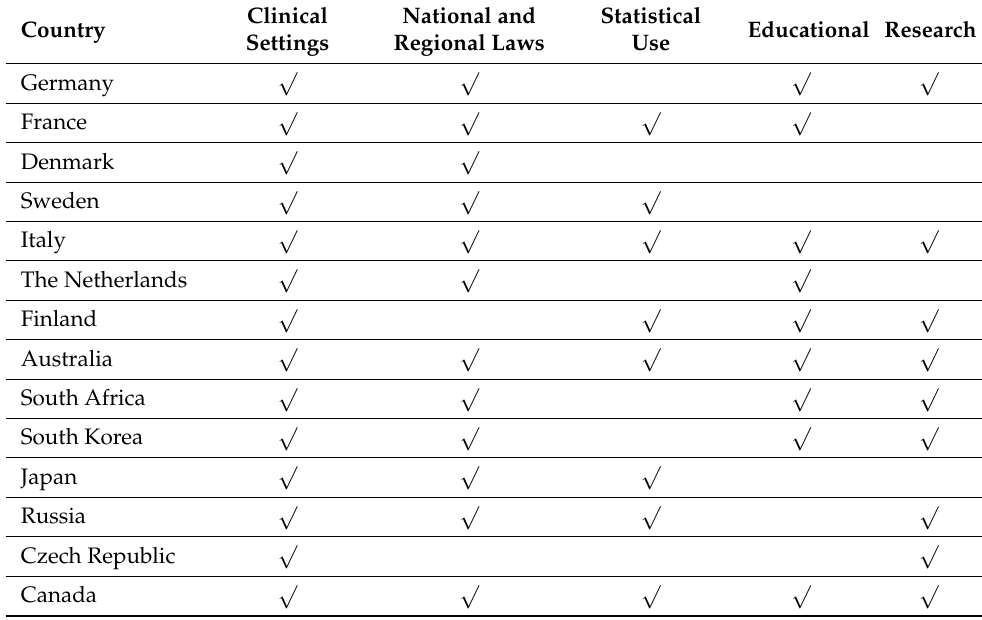
Figure 2. Main use of ICF in respondent countries (N = 14). Table 1. Main uses of ICF reported by WHO FIC CCs. Tables show the frequency of ICF implemen- tation in different areas for each country.